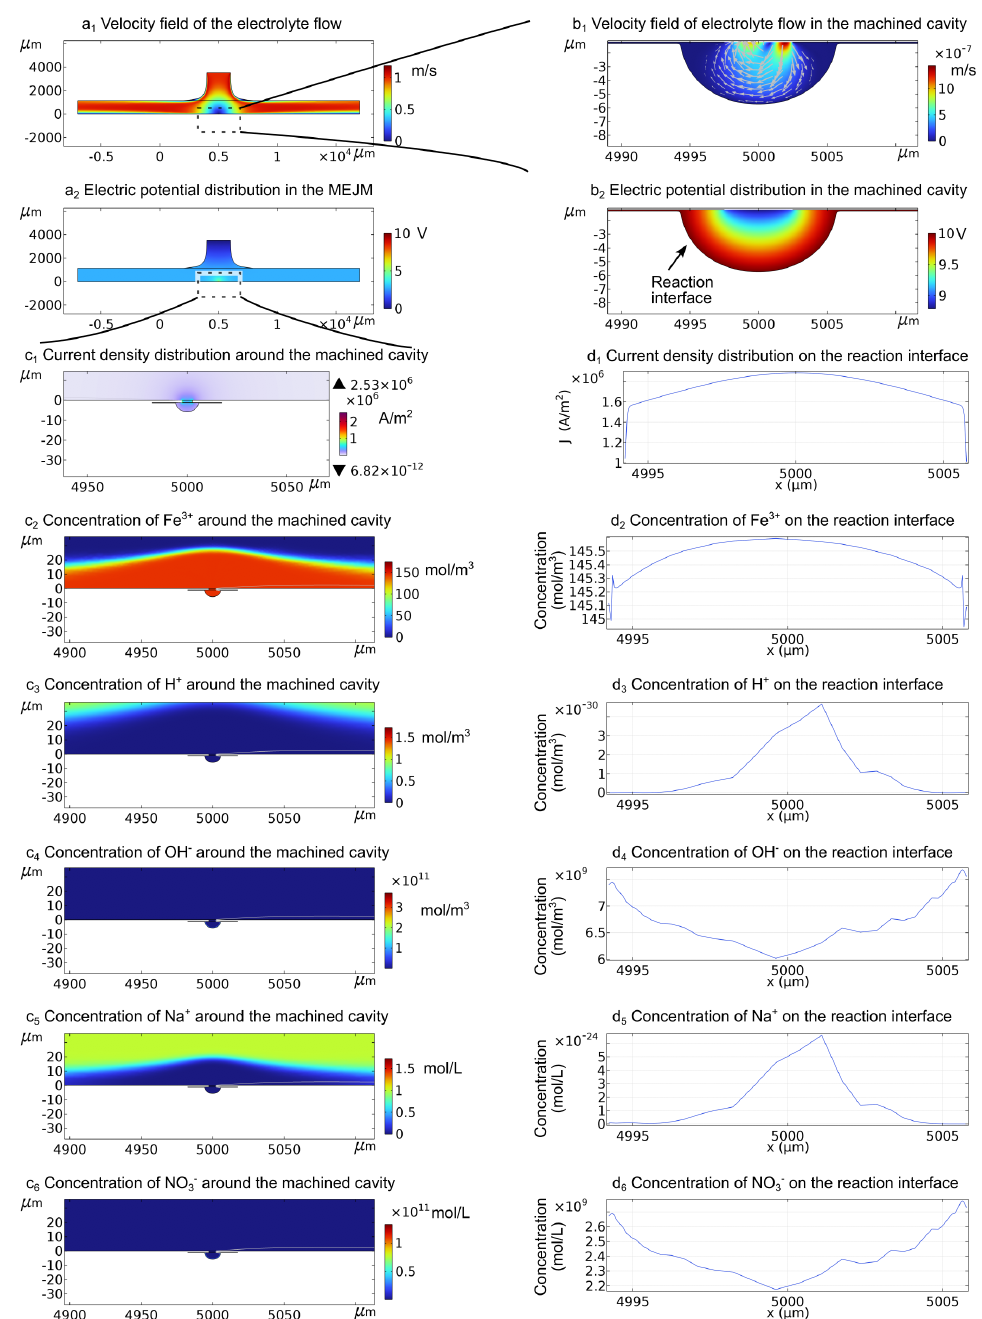
Figure A3. Simulation results at t = 2 s. ( a 1 ): velocity field of the electrolyte flow; ( b 1 ): velocity field of electrolyte flow in the machined cavity; ( a 2 ) electric potential distribution in the MEJM; ( b 2 ) electric potential distribution (V) in the machined cavity; ( c 1 ) normal current density distribution around the machined cavity; ( d 1 ): normal current density distribution on the reaction interface; ( c 2 – c 6 ): concentration ( mol/m 3 ) of Fe 3+ , H + , OH – , Na + , and NO 3– around the machined cavity; ( d 2 – d 6 ): concentration (mol/m 3 ) of Fe 3+ , H + , OH – , Na + , and NO 3– on the reaction